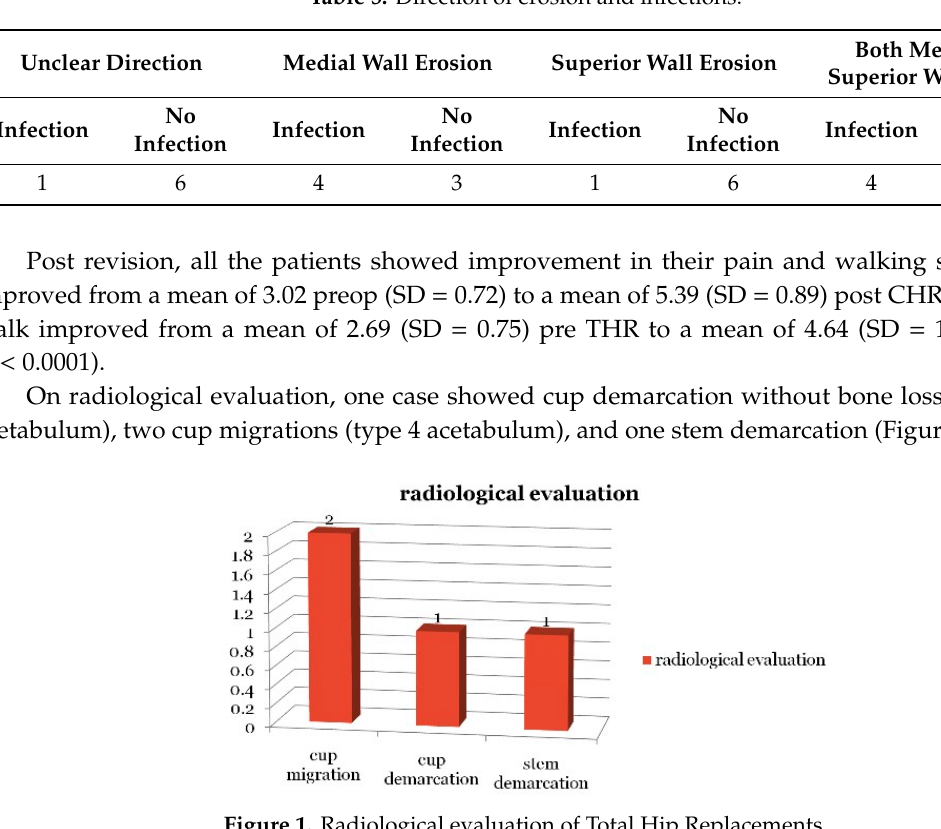
Table 6. Complications following conversion surgeries. Post-Revision Complications Figure 2. Kaplan Meier survival analysis. 4. Discussion Previous studies suggest a high incidence of complications following the revision of hemiarthroplasty to a THR, particularly dislocation and early loosening [3,11]. In our case series, the 0.00.30.50.81.0 0